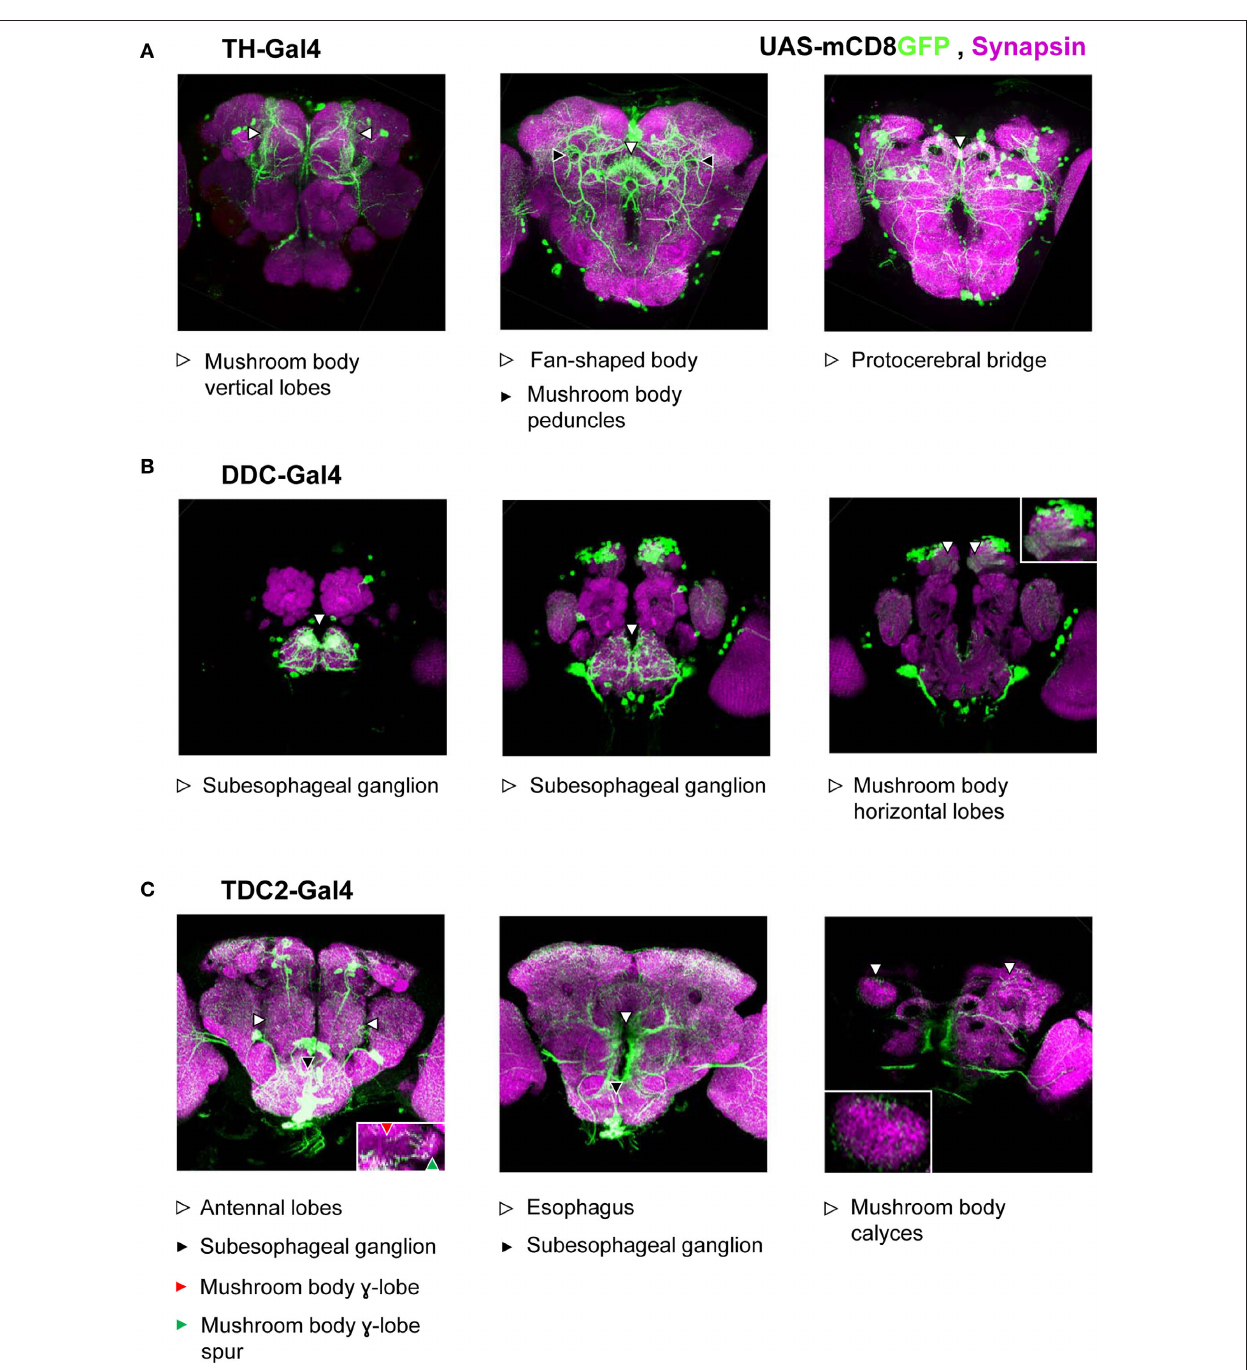
panel) and the protocerebral bridge (right panel). We found no innervation of the antennal lobes or the mushroom body calyces (but see Mao and Davis, 2009). Under the control of the DDC-Gal4 driver (B) , GFP was expressed in neurons that innervate the subesophageal ganglion (left and middle panels) as well as the horizontal lobes of the mushroom body (right; see also the inset). Neurons that express GFP, driven by TDC2-Gal4 (C) innervated the antennal lobes (left panel), mushroom body γ -lobes and their spurs (left panel, inset), the subesophageal ganglion (left and middle panels), the areas surrounding the esophagus (middle panel), and the mushroom body calyces (right panel; see also the